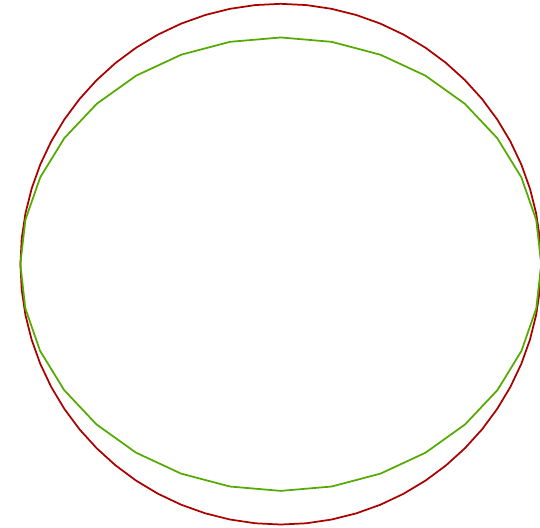
Figure 3: Difference of buffering approaches aroud latitude = − 30 o and longitude = − 51 o . The red line is a buffer of 0 . 1 o using standard geometry data type and the green line is a buffer of 9648m around the same point using the geography data type